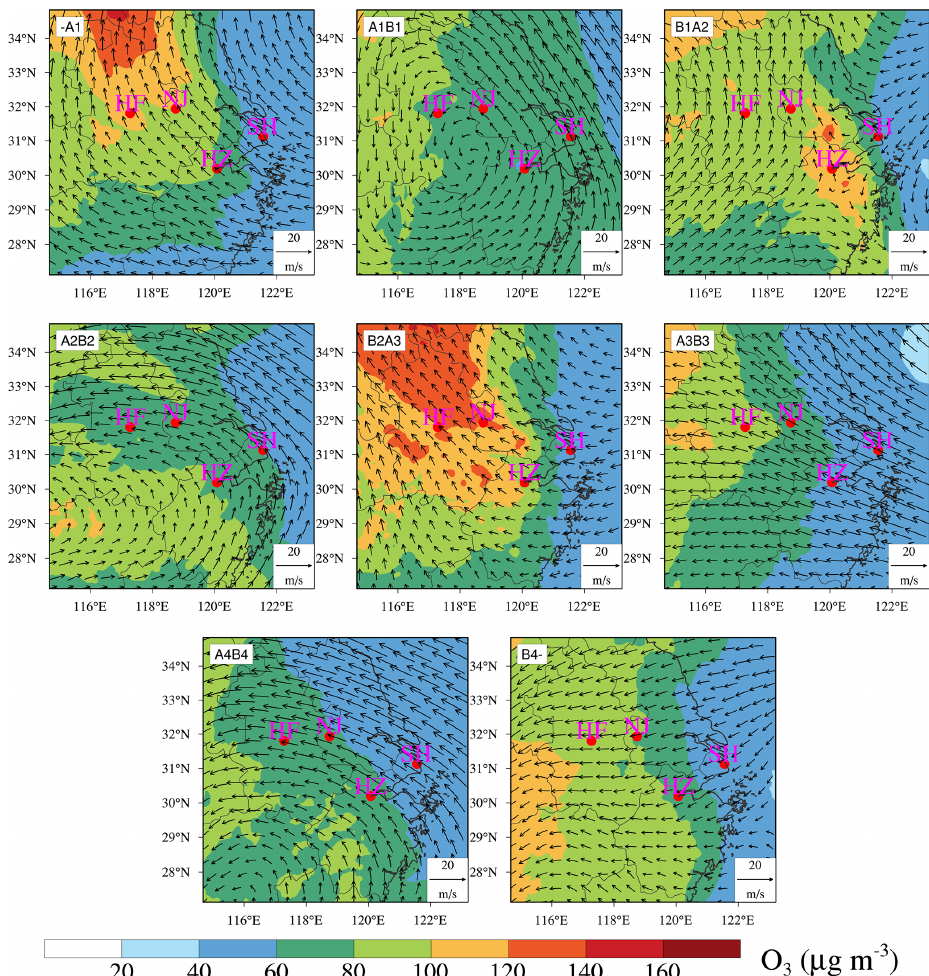
Figure 7. Spatial distribution of surface O 3 overlaid with wind fields at 850hPa over the YRD. -A1, A1B1, B1A2, A2B2, B2A3, A3B3, A4B4 and B4- are the average results from the beginning to A1, A1 to B1, B1 to A2, A2 to B2, B2 to A3, A3 to B3, A4 to B4 and B4 to the end, respectively. Details can be found in Fig.